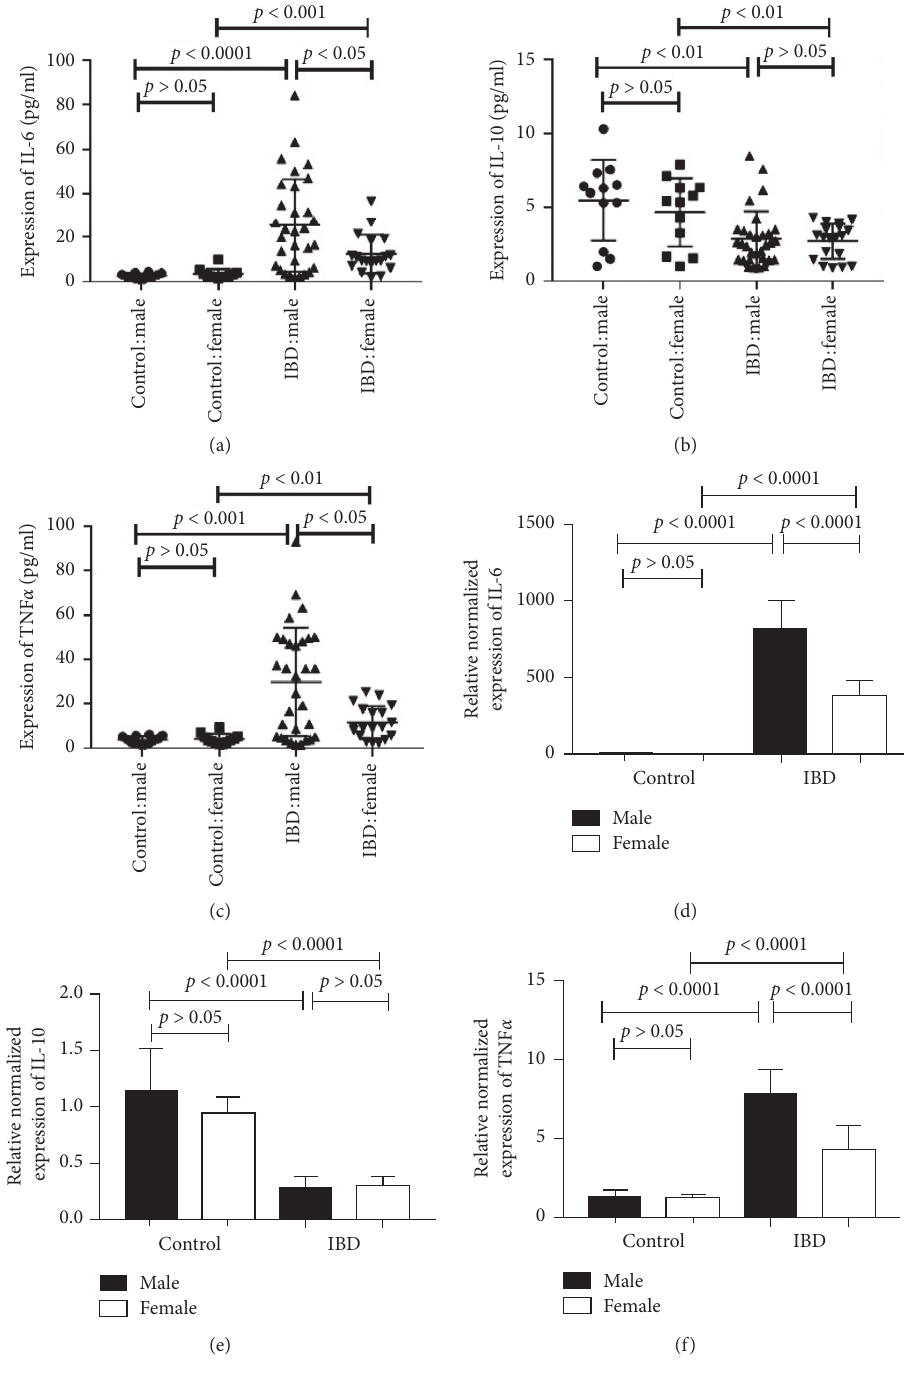
Figure 1: The expression of IL-6 and TNF α in male IBD patients is higher than in female patients. 1a and d expression of IL-6 in the serum (a) and tissue (d) of the IBD patients and control group. (b, e) Expression of IL-10 in the serum (b) and tissue (e) of the IBD patients and control group. (c, f) Expression of TNF α in the serum (c) and tissue (f) of the IBD patients and control. The values are presented as the mean ±